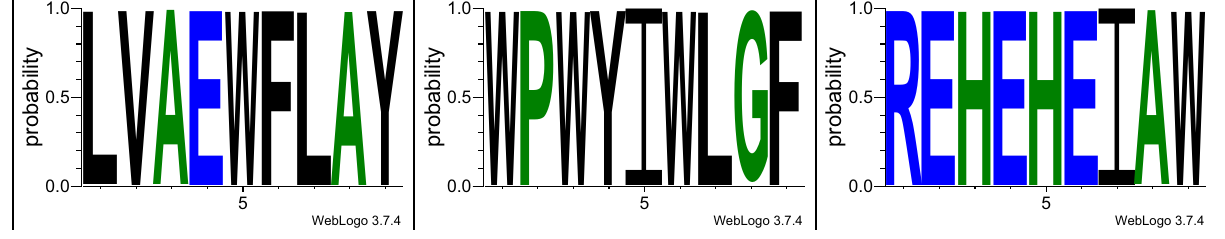
Figure 5. The sequence logos of the identified epitopes.